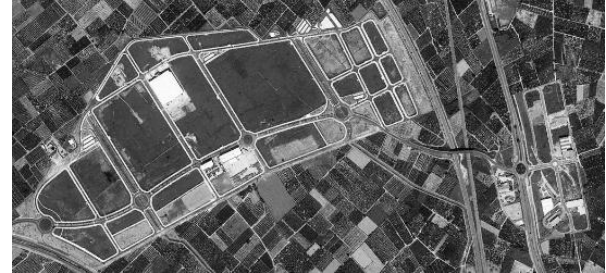
Figure 16. Guadassuar.Valencia.Spain after 2007 crisis.